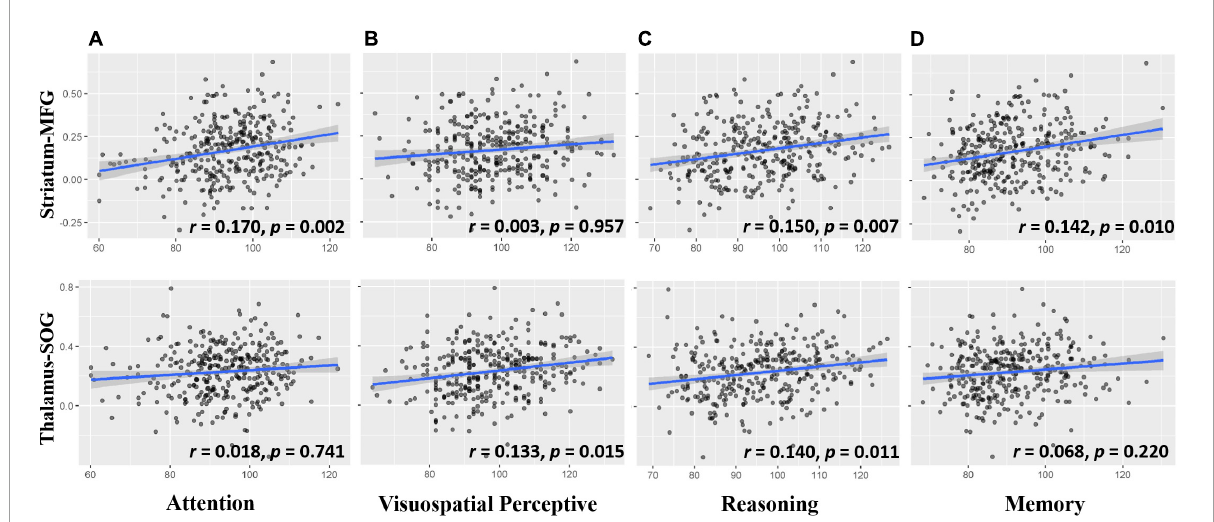
FIGURE5 Scatter plots for the correlation between cortico-subcortical functional connectivity and cognitive ability (A) Attention ability related to striatum-MFG, but not thalamus-SOG; (B) visuospatial perceptive ability related to thalamus-SOG, but not striatum-MFG; (C) reasoning ability was associated with striatum-MFG and thalamus-SOG; (D) memory ability was associated with striatum-MFG, but not thalamus-SOG. The upper row is the striatum-MFG and the lower row is the thalamus-SOG. Striatum-MFG, functional connectivity between left striatum and left middle frontal gyrus; Thalamus-SOG, functional connectivity between right thalamus and right superior occipital gyrus. Age, sex, handedness, site, household income, parental education, and head motion were used as covariates of no